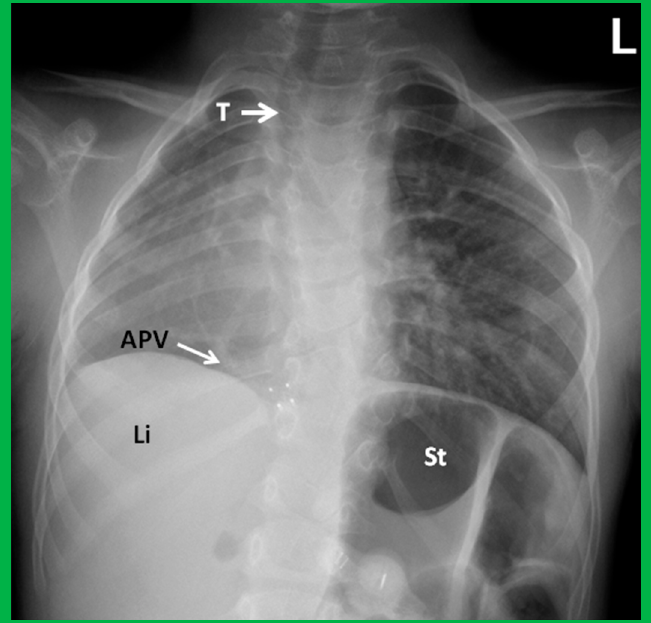
Figure 5. A chest roentgenogram of a child with dextroposition of the heart related to Scimitar syndrome. Hypoplastic right lung pulls the heart to the right. Note that the trachea (T) is displaced to the right, related hypoplastic right lung. An anomalous pulmonary vein (APV) is pointed out by an arrow; the name, Scimitar syndrome is derived from the sickle shape of the APV. Li, liver; St, stomach. Reproduced from reference [4].